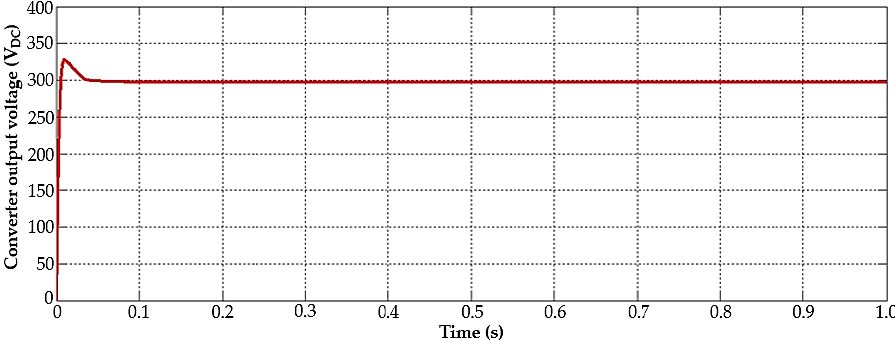
Figure 5. The output voltage waveform of the modified LUO converter using the GWO algorithm.